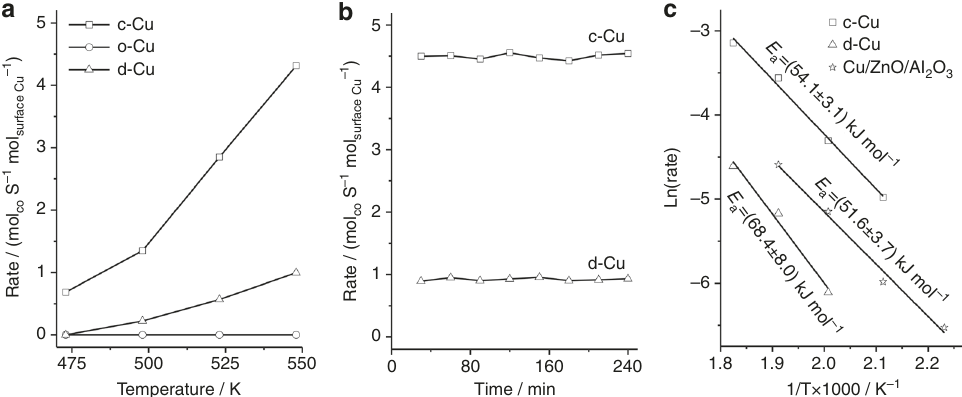
Fig. 2 Catalytic performance. a Reaction rate (mol CO s − 1 mol surface Cu − 1 ) of Cu cubes (c-Cu), octahedra (o-Cu), and rhombic dodecahedra (d-Cu) in the WGS reaction as a function of reaction temperature. b Reaction rate of Cu cubes (c-Cu) and rhombic dodecahedra (d-Cu) at 548 K in the WGS reaction as a function of reaction time. c Arrhenius plots of Cu cubes (c-Cu) and rhombic dodecahedra (d-Cu) and commercial Cu/ZnO/Al 2 O 3